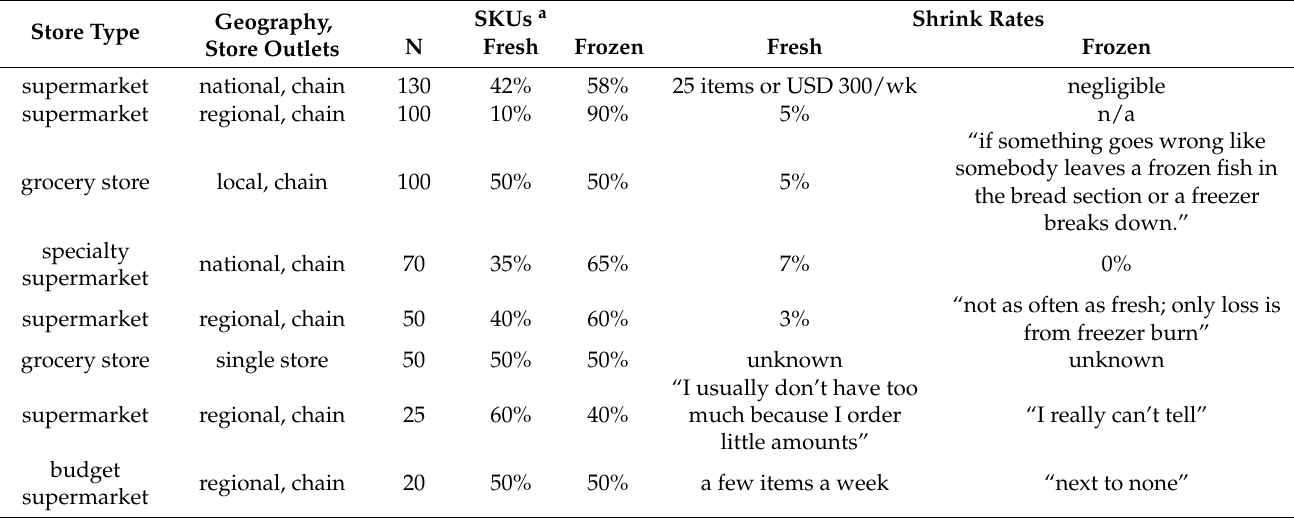
Table 1. Seafood shrink rates in Baltimore, Maryland area grocery stores and supermarkets by product